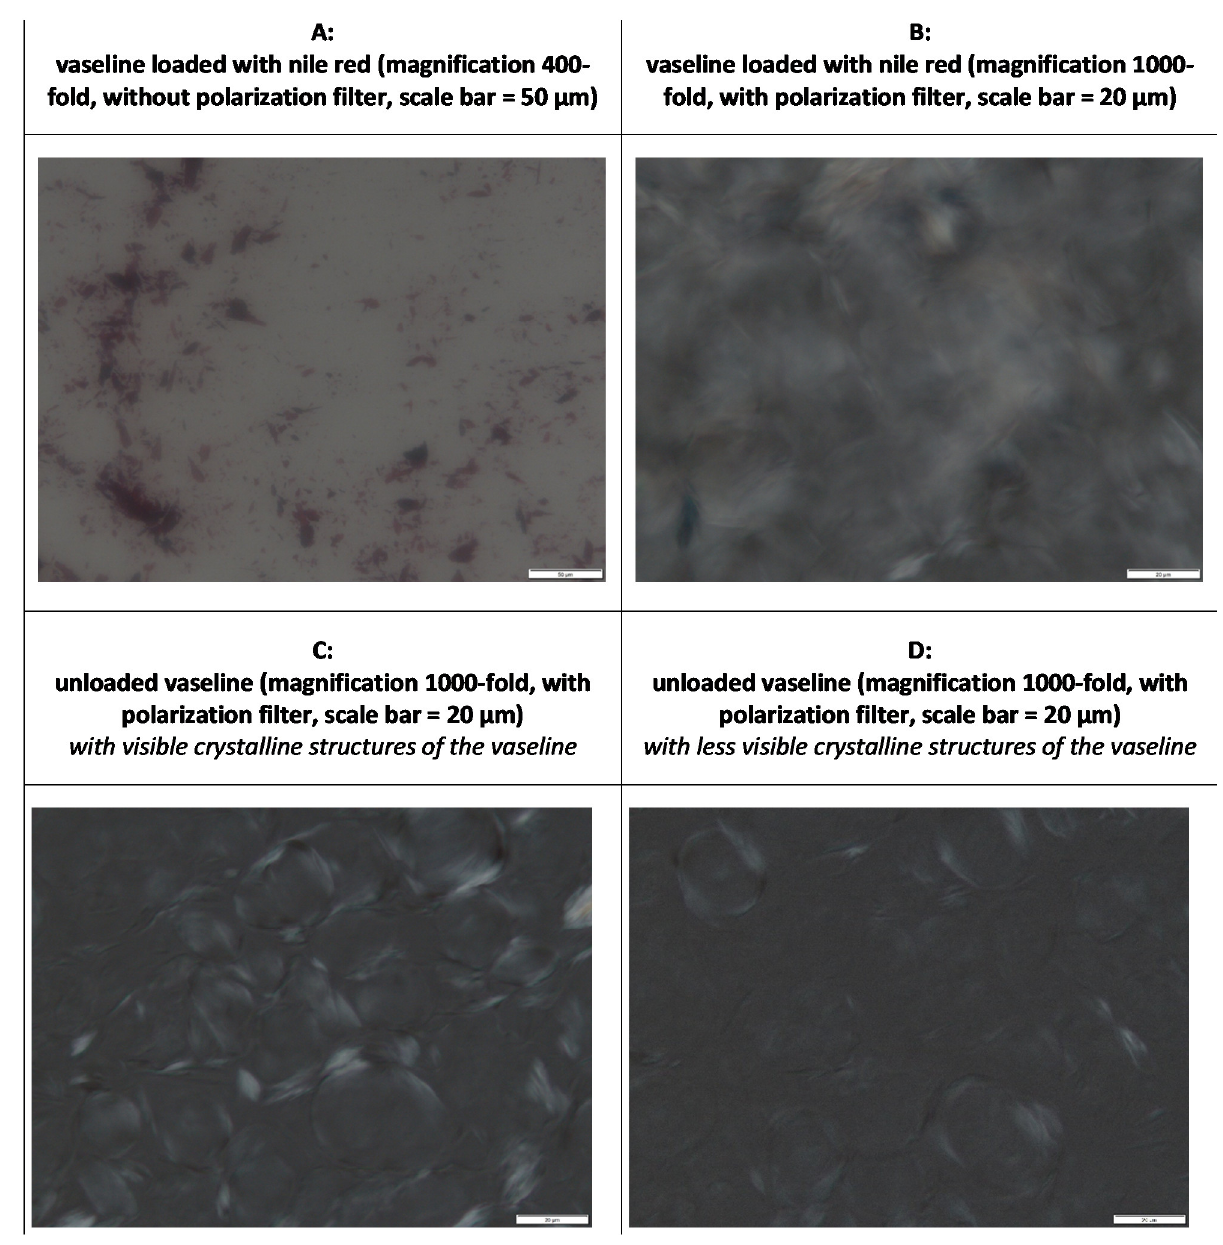
Figure 3. Microscopic images of Nile red-loaded Vaseline ( upper ) and unloaded Vaseline ( lower )—for further explanations cf. text.